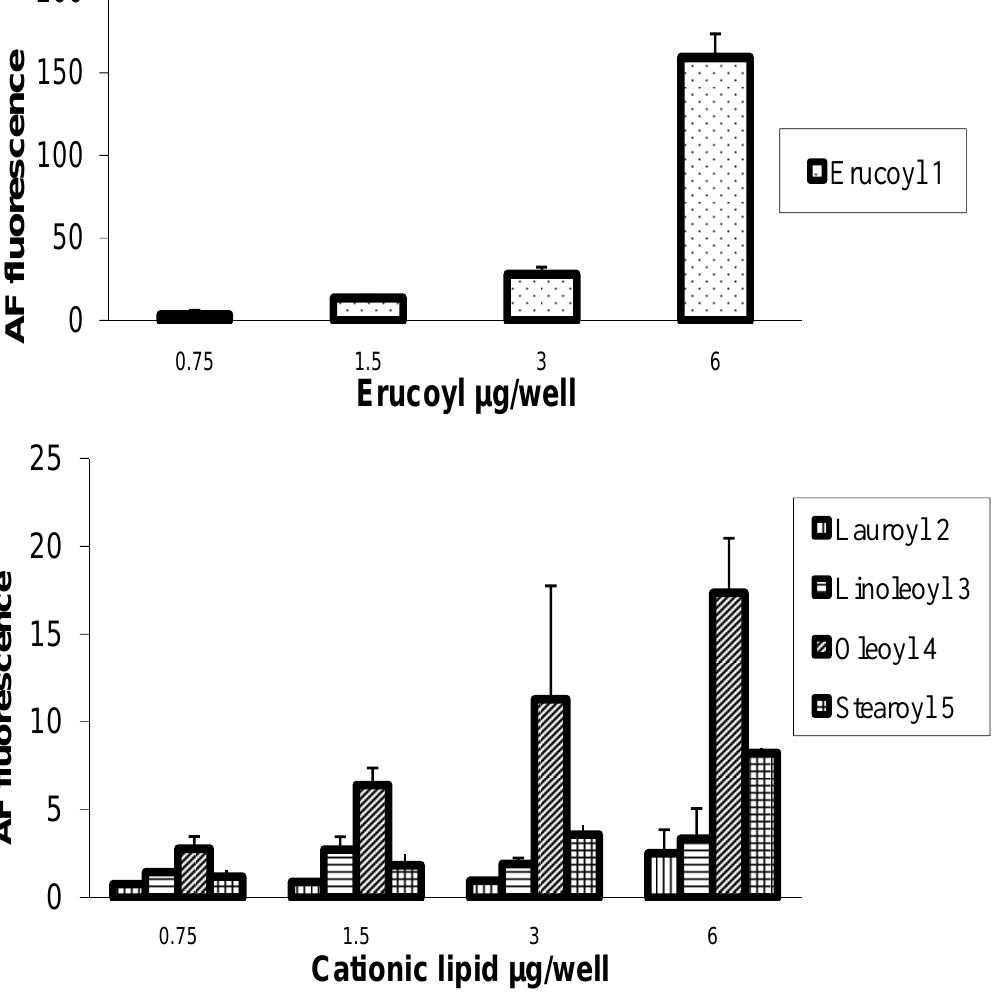
Figure 3. Upper : siRNA delivery using 1 . Values are presented as mean of normalized geometric mean fluorescence ± SD (n = 6). Lower : siRNA delivery measured as the normalized values of Alexa Fluor 647 (AF) geometric mean fluorescence using 2-5